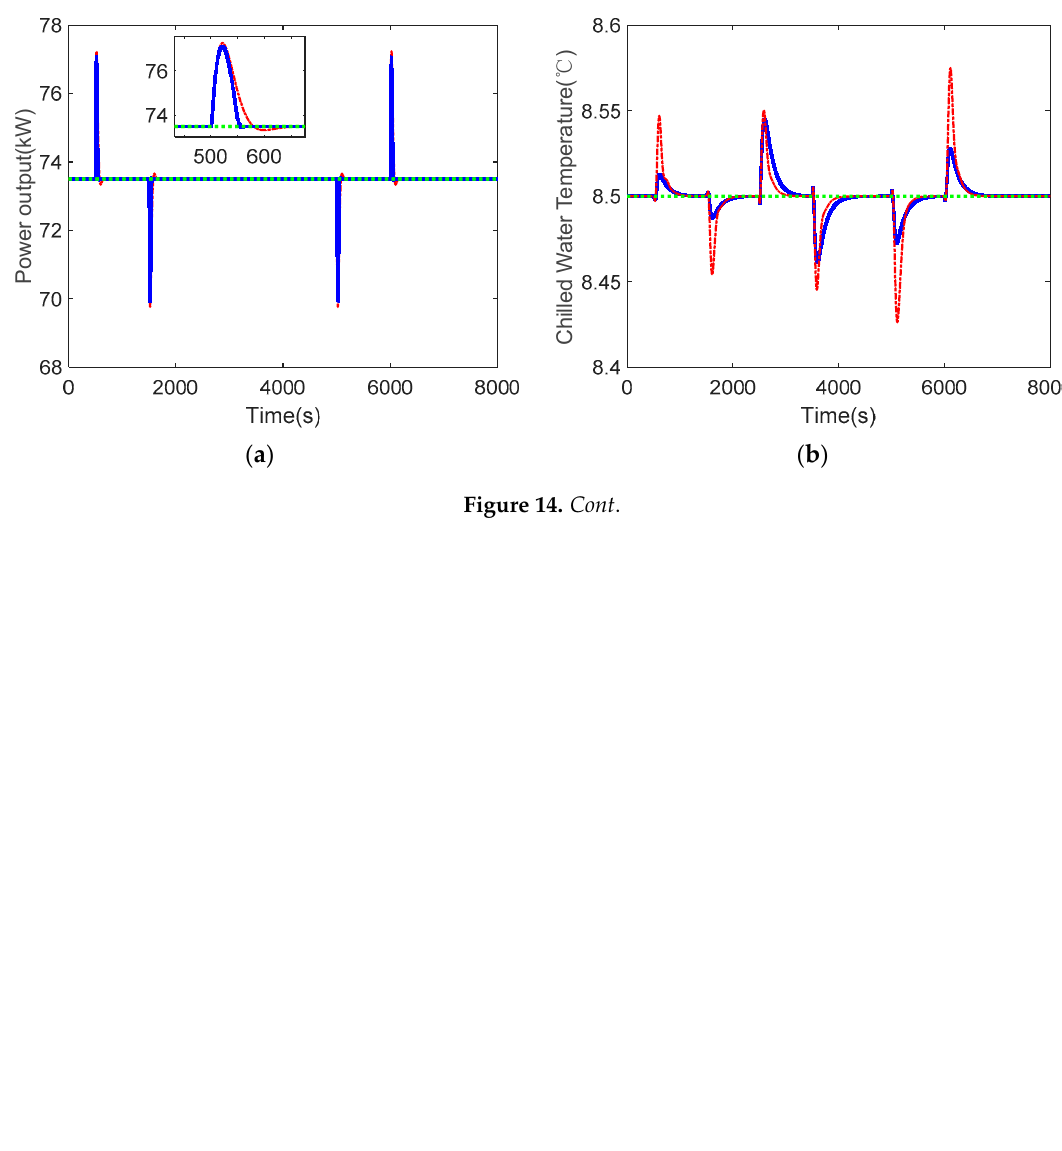
Figure 13. Unknown input disturbances.